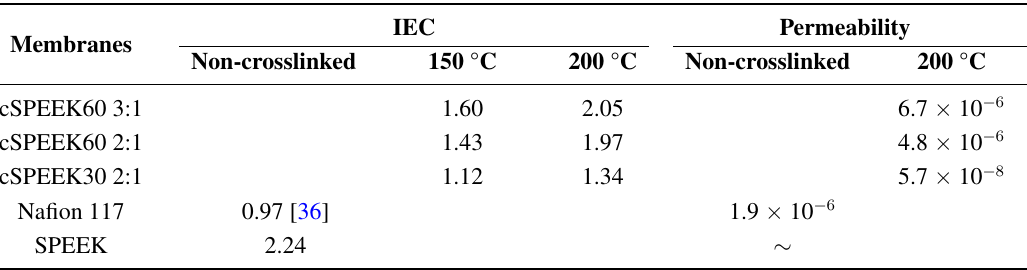
Ion exchange capacity (IEC; meq/g) and vanadium permeability (cm 2 s − 1 ) of observed membranes (sample code: cSPEEK60 2:1 = crosslinked SPEEK with